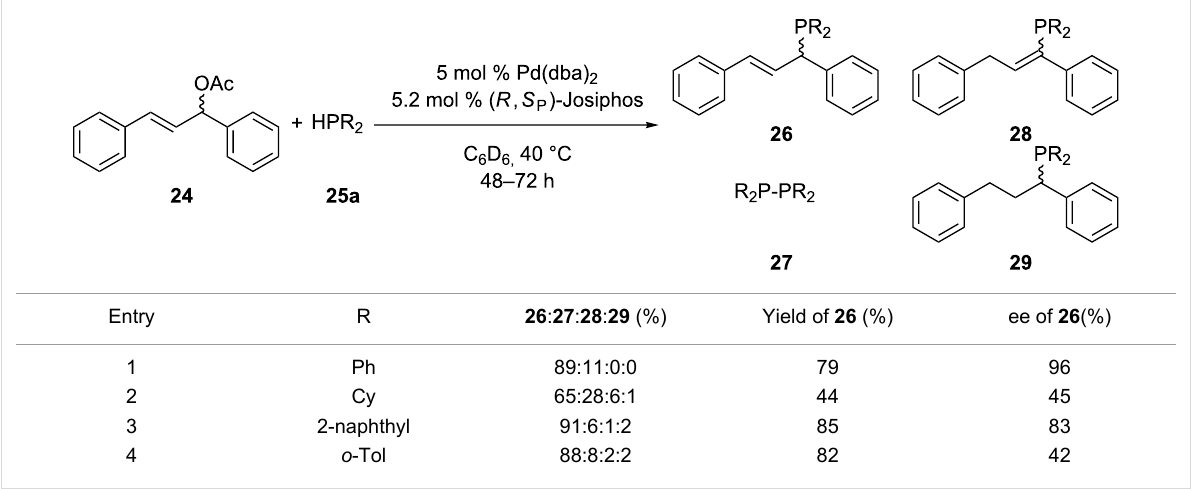
Table 2: Palladium-catalyzed asymmetric allylic phosphination (dba =